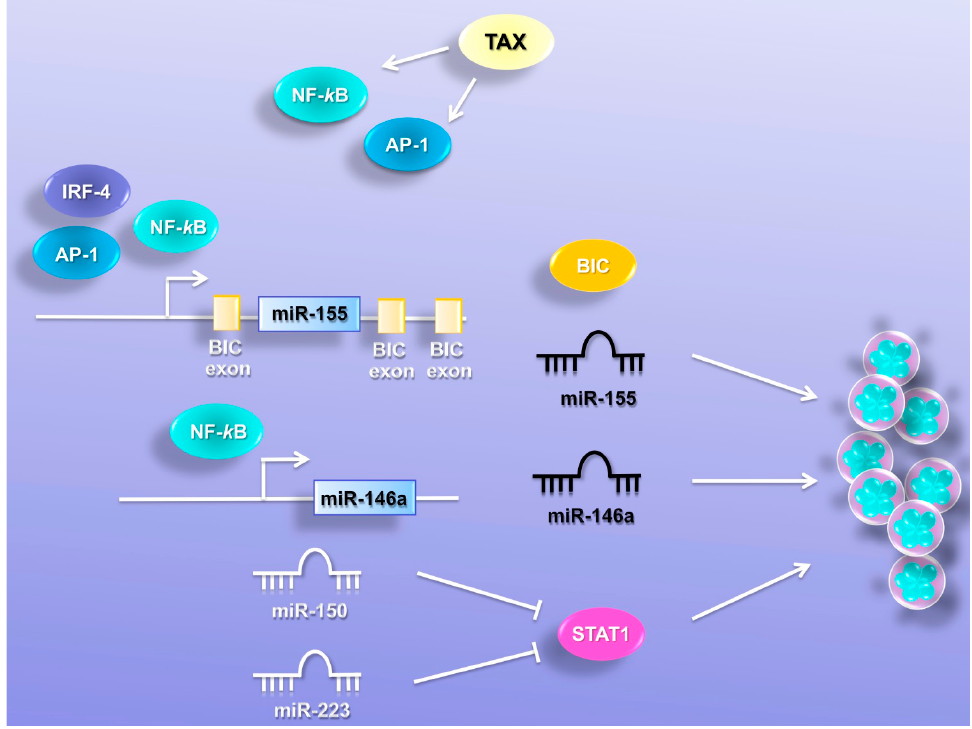
Figure 3. MiRNAs promote cell proliferation. MiR-155 and miR-146a were